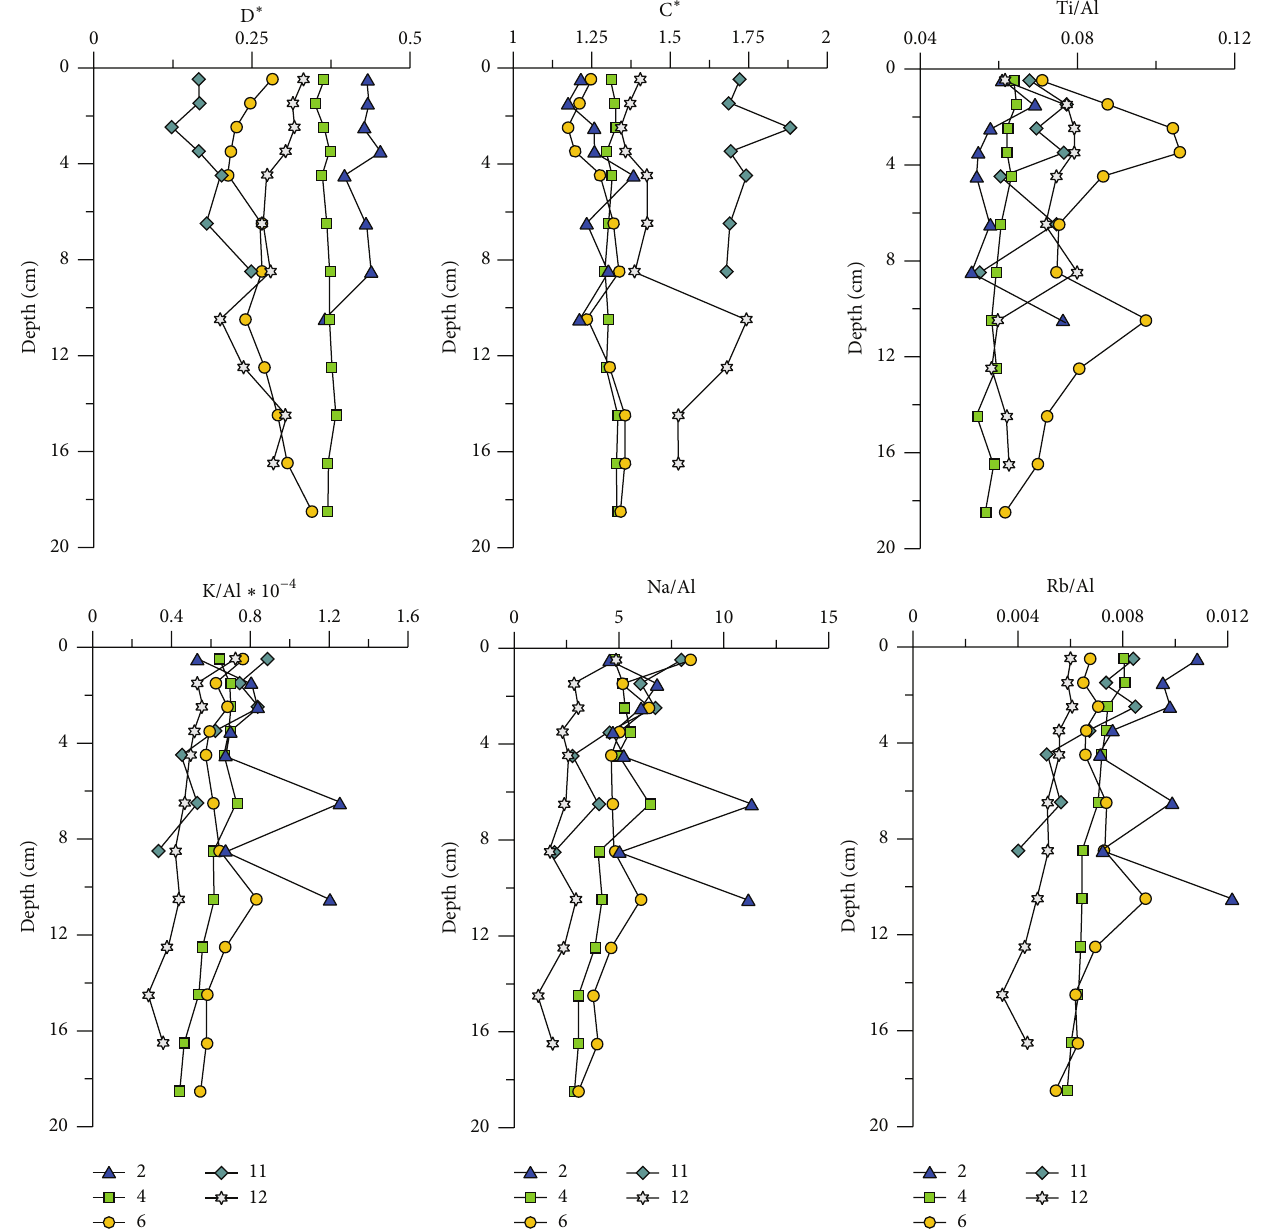
Figure 3: Depth profiles of D ∗ , C ∗ , Ti/Al, K/Al ∗ 10 −4 ; Na/Al and Rb/Al for lake Specchio di Venere sediment cores.